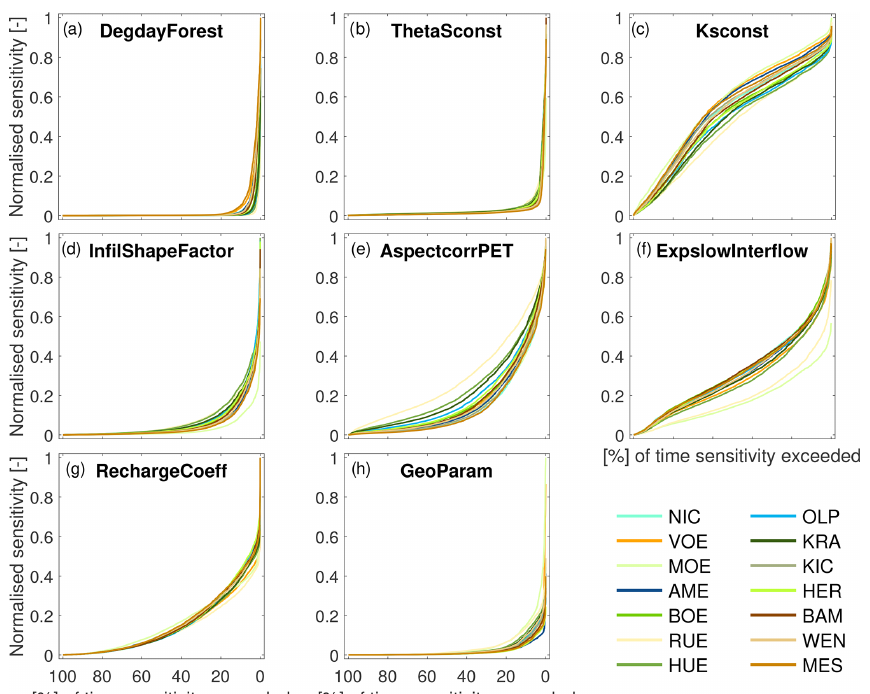
Figure 4. Sensitivity duration curves (SDCs) for eight global mHM parameters of 14 Ruhr headwater catchments (1997–2006): DegdayFor- est (a) , ThetaSconst (b) , Ksconst (c) , InfilShapeFactor (d) , AspectcorrPET (e) , ExpslowInterflow (f) , RechargeCoeff (g) , and GeoParam (h) . SDCs are shown normalised by the highest sensitivity value for each parameter among the headwaters. The eight parameters in terms of their average importance to streamflow simulations (TEDPAS) among all headwaters listed in descending order: Ksconst, AspectcorrPET, ExpslowInterflow, RechargeCoeff, ThetaSconst, InfilShapeFactor, GeoParam, and